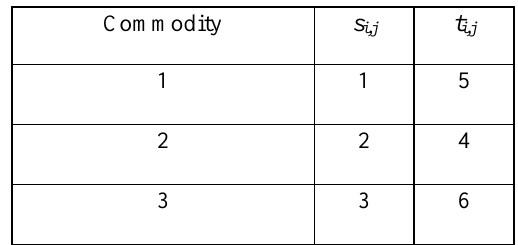
Table 3: Pairs of source-target nodes